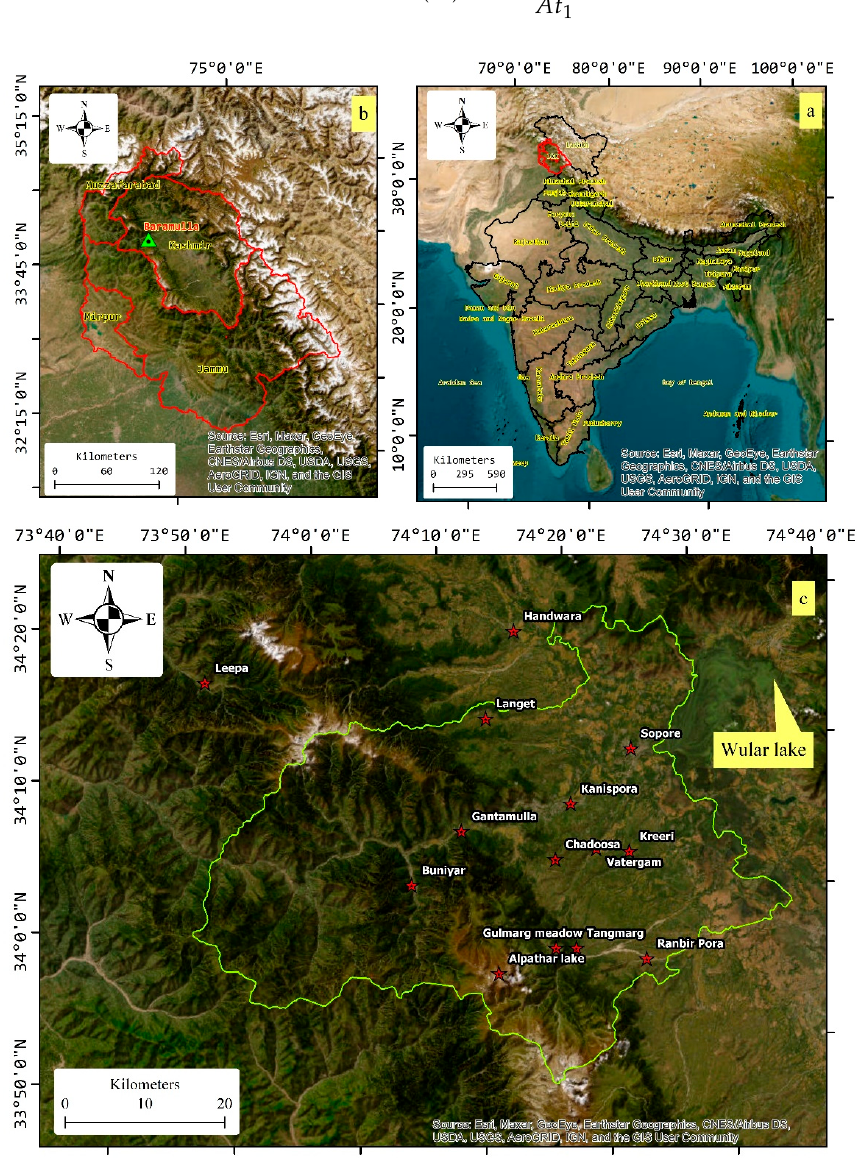
Figure 1. ( a ) The union of India ( b ) UT of Jammu and Kashmir ( c ) Baramulla district. The map coordinates are UTM WGS-84 North, and various prominent landmarks are shown on the map . Table 1. Site characters and natural vegetation of the study area.